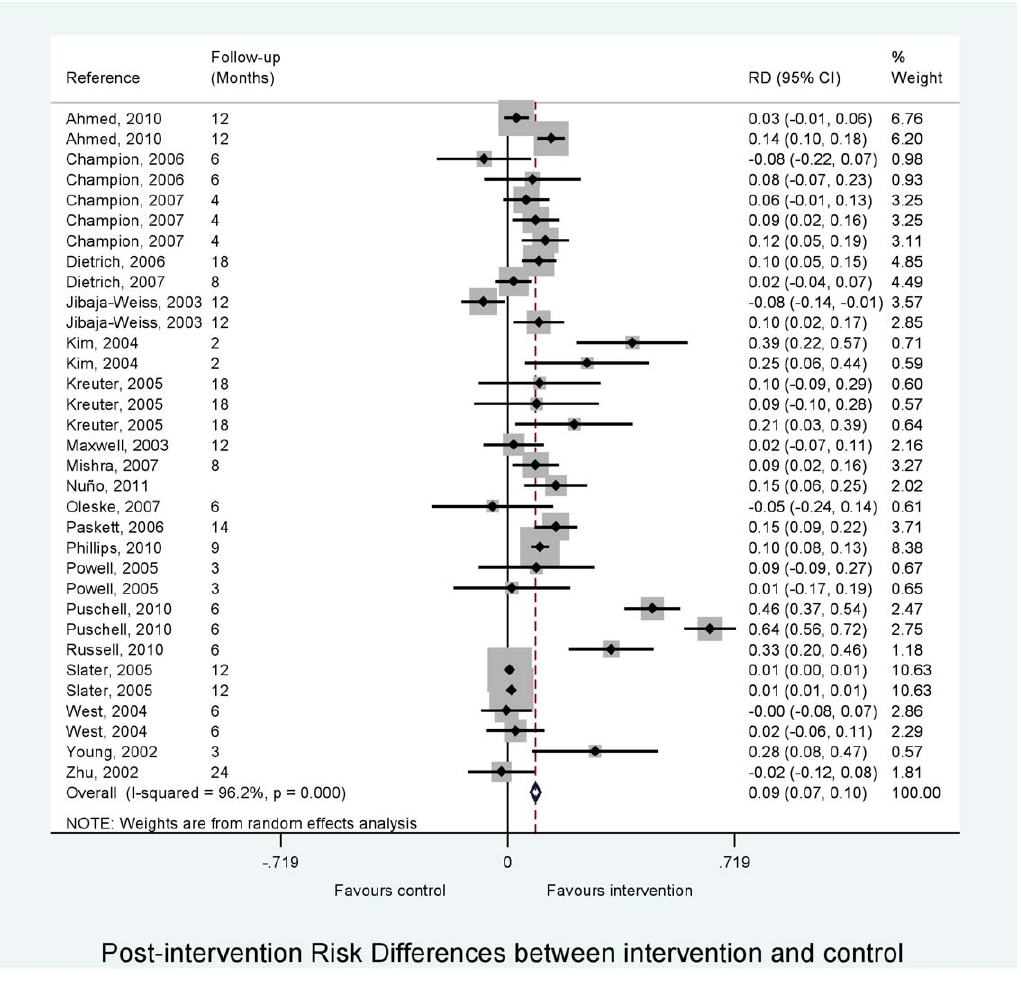
Figure 2. Meta-analysis of the association between intervention and mammography uptake in low income women.